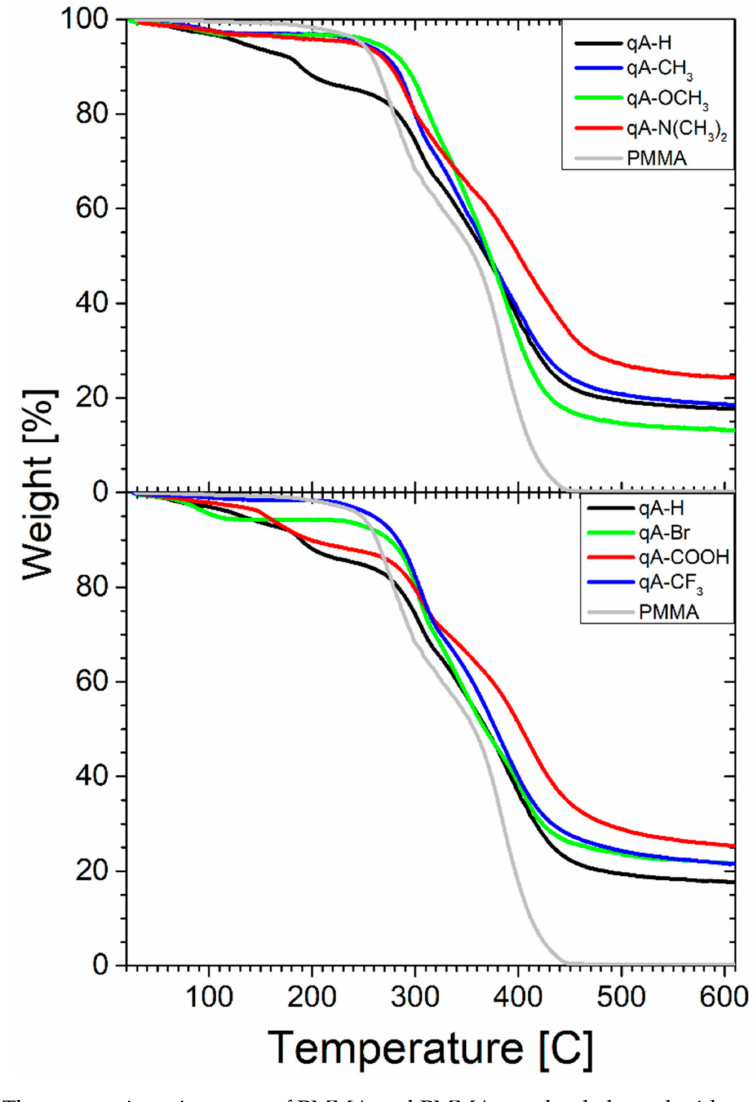
Figure 2. Thermogravimetric curves of PMMA and PMMA covalently bound with